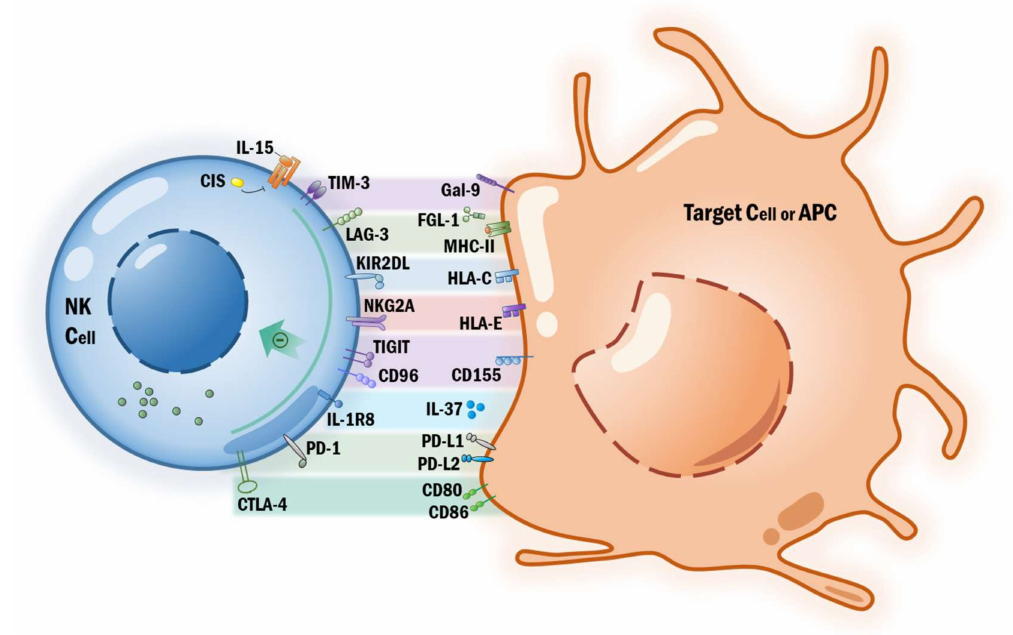
Figure 1. NK cell immune